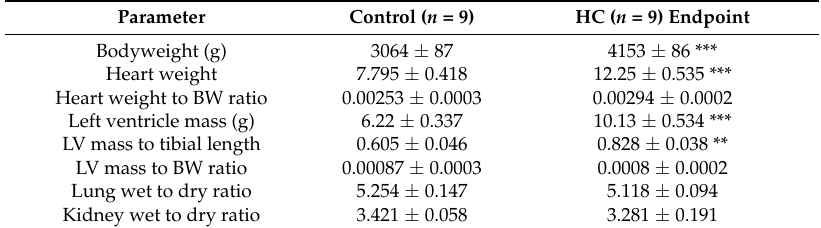
Table 3. Body-, heart- and left ventricle weight, LV mass to tibial length ratios, lung and kidney wet to dry tissue ratios at the endpoint of the study. Asterisks denote the level of statistical significance compared to Control (** p < 0.01; *** p < 0.001; Student’s t -test).